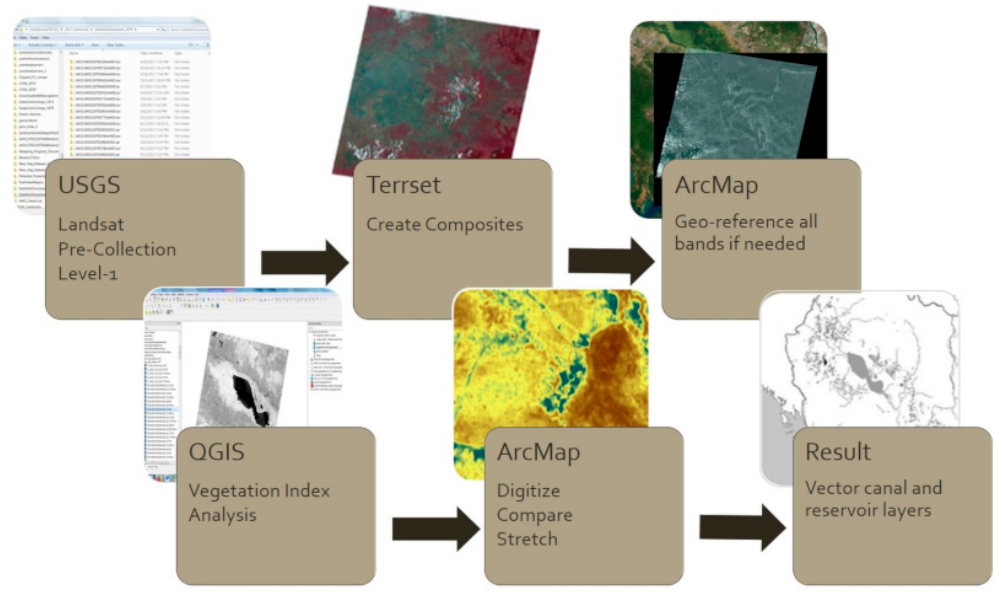
Figure 3. Landsat image processing workflow.